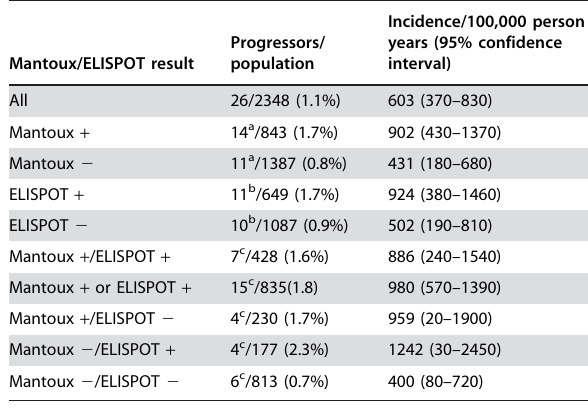
* Abbreviations used: EP, extrapulmonary; SPXRP, sputum positive/X-ray positive; SNXRP, sputum negative/X-ray positive; SNCP, sputum negative/culture positive; SPCP, sputum positive/culture positive; SNCNXRP, sputum negative/culture negative/X-ray positive doi:10.1371/journal.pone.0001379.t002 Table 3. Incidence rate of progression to disease, in TB case contacts, according to initial Mantoux and/or ELISPOT results. .. ... .... ... ... .... ... ... .... ... ... .... ... ... .... ... ... .... ... ... ....